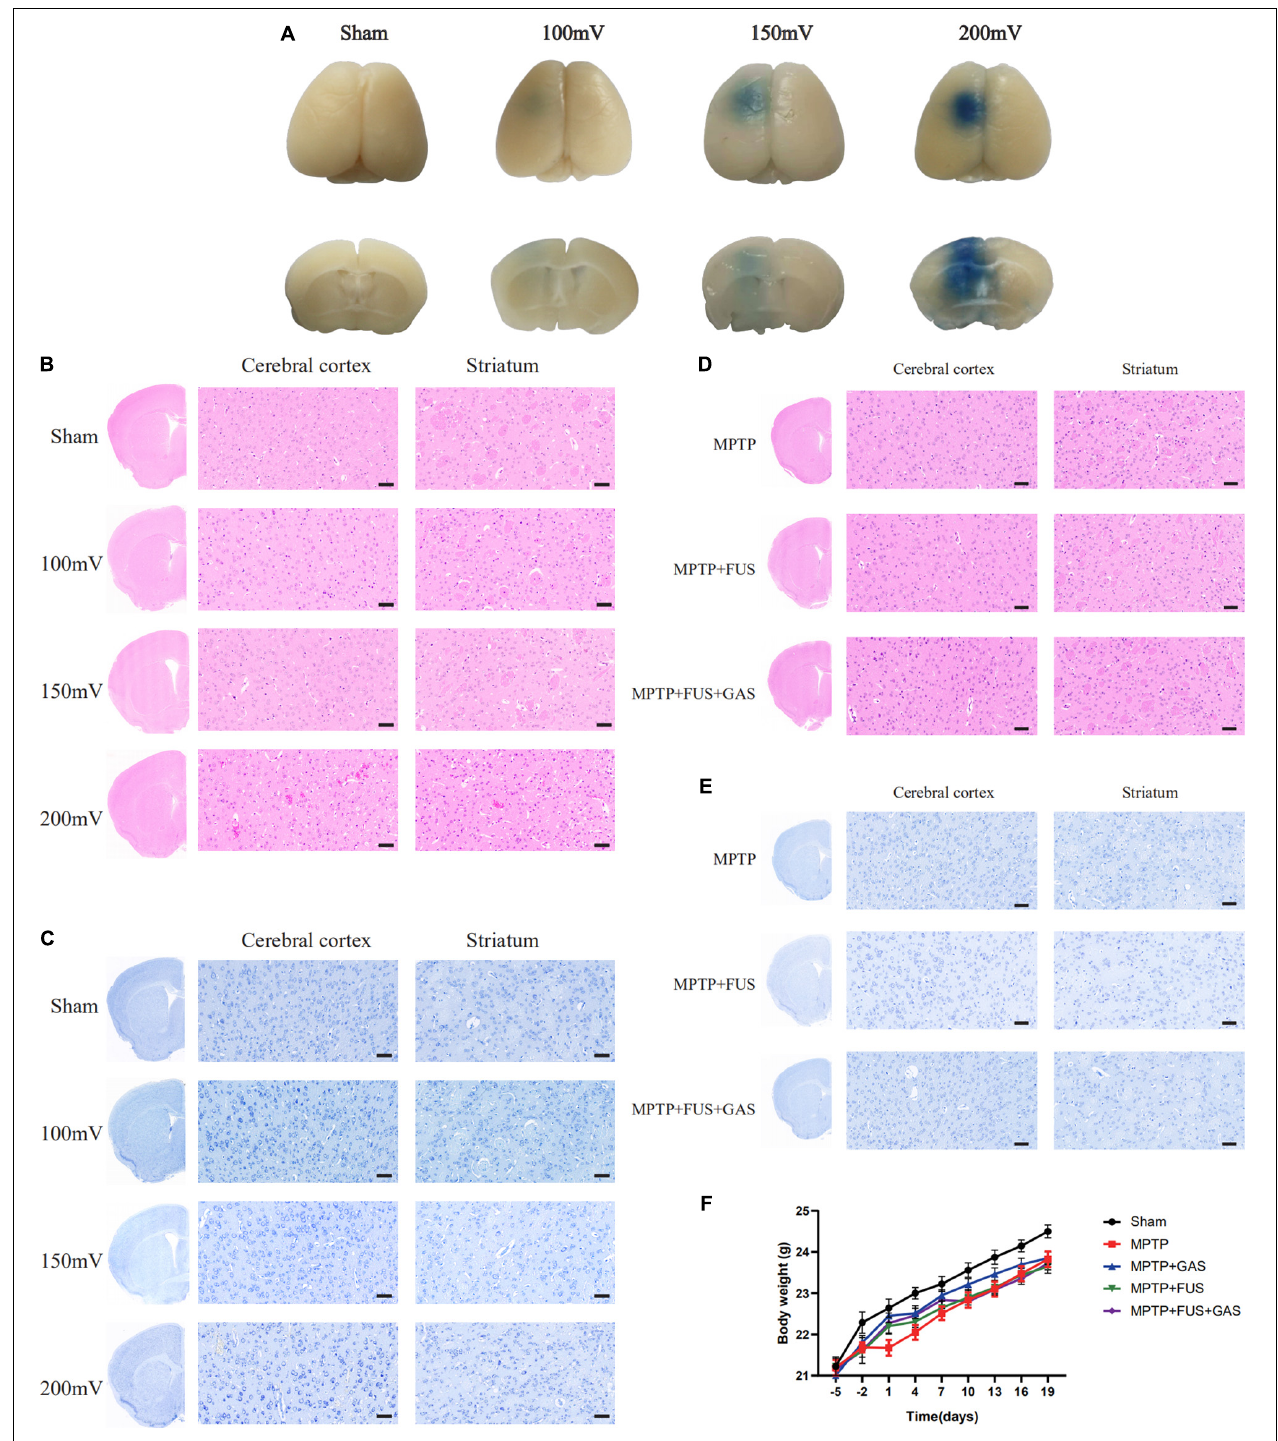
FIGURE 2 | Efficacy and safety of focused ultrasound (FUS)-induced blood–brain barrier (BBB) opening. (A) Penetration of Evans blue in the brains of mice in different groups 4 h after FUS-induced BBB opening, n = 3. (B) H&E staining results of sonicated cerebral cortex and striatum in different groups 4 h after FUS-induced BBB opening, n = 3, scale bar = 50 µ m. (C) Nissl staining results of sonicated cerebral cortex and striatum in different groups 4 h after FUS-induced BBB opening, n = 3, scale bar = 50 µ m. (D) H&E staining results of sonicated cerebral cortex and striatum in Parkinson’s disease (PD) mice after a total of six times’ BBB opening induced by FUS, n = 3. Scale bar = 50 µ m. (E) Nissl staining results of sonicated cerebral cortex and striatum in PD mice after a total of six times’ BBB opening induced by FUS, n = 3. Scale bar = 50 µ m. (F) The body weight change curve of mice in each group.